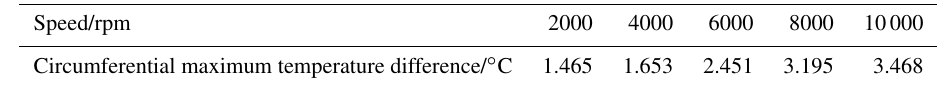
Table 5. The maximum temperature difference of circle 1 at different rotating